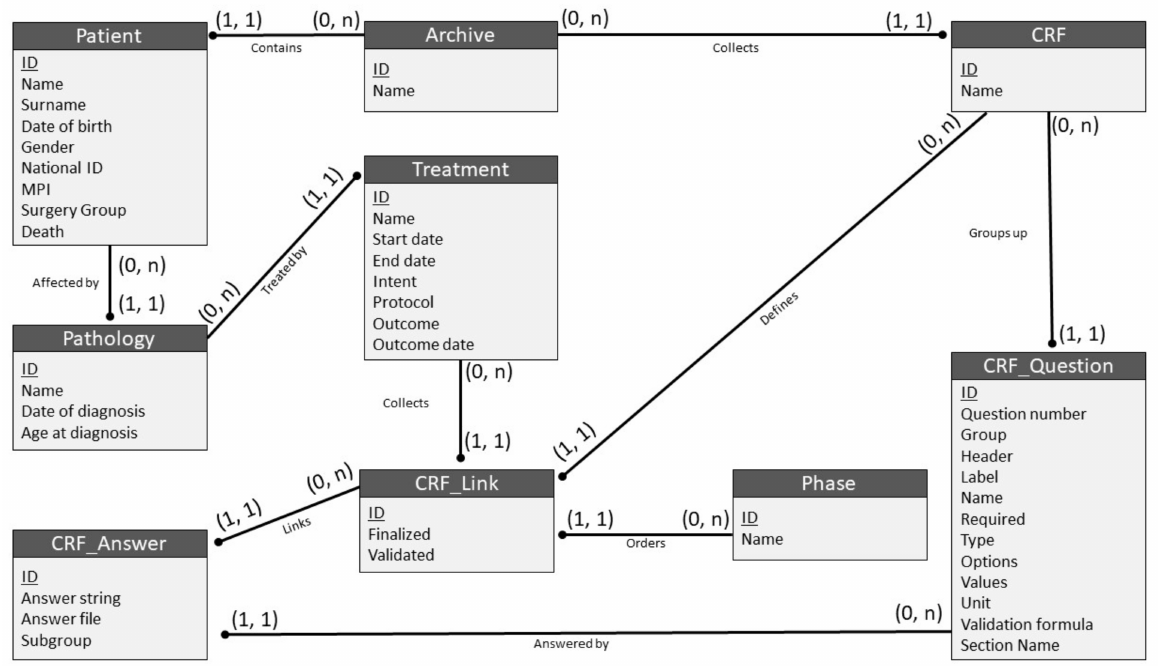
Figure 3. Underlying BOA data model visualized through an entity–relationship model that highlights all relationships between the different objects in the database. As an example (and using imaginary values), the archive named BLADE would contain a patient named John Doe, affected by a pathology of breast cancer, for which he was treated through a treatment of first treatment. This treatment would have a compiled version of the case report form (CRF) radiotherapy linked to the phase called neoadjuvant, and an answer of prone, to the question of radiotherapy treatment position present in the previously mentioned